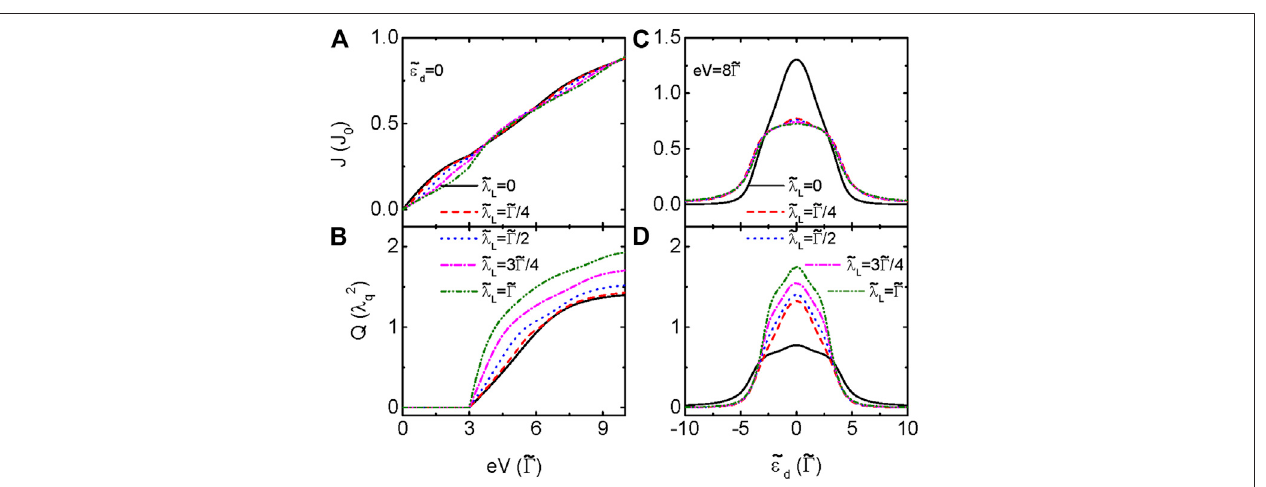
FIGURE2| Electricalcurrent (A) andheatgeneration (B) asfunctionsofthebiasvoltagefor ~ ε d (cid:1) 0atdifferent ~ λ L . (C,D) Electricalcurrentandheatgenerationvsthe dot level for eV (cid:1) 8 ~ Γ and different ~ λ L . Other parameters are ω q (cid:1) λ q (cid:1) 3 ~ Γ , δ M (cid:1) ~ λ R (cid:1) 0, and T e (cid:1) T p (cid:1) 0 . 00025 ~ Γ .